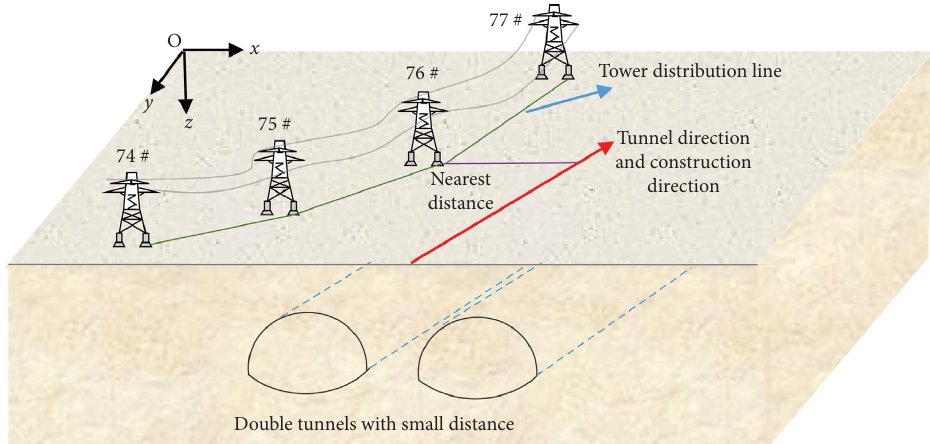
Figure 1: Schematic diagram of the position relationship between the tunnel and the upper high-voltage tower.